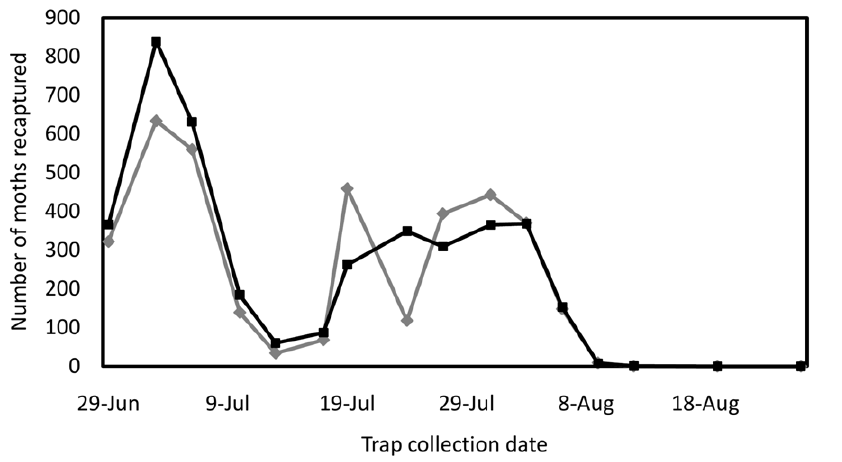
Figure 5. Number of OX1138B and APHIS male moths recaptured in all fields during the trial period. Black line=OX1138B; grey line=APHIS.